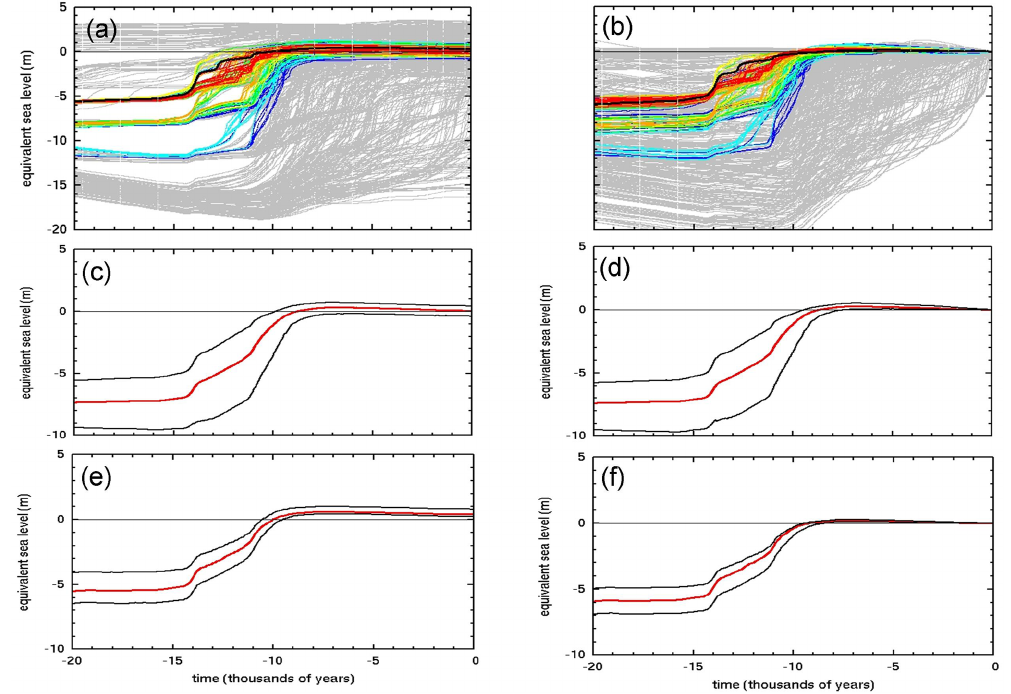
Figure 5. Equivalent global-mean sea-level contribution (ESL) relative to modern vs. time. Time runs from 20000yr before present to modern. ESL changes are calculated from the total ice amount in the domain divided by global ocean area, allowing for less contribution from ice grounded below sea level. (a) Scatterplot of all 625 individual runs in the LE. ESL amounts are calculated relative to modern observed Antarctica, so non-zero values at time = 0 imply departures from the observed ice state. Grey curves are for runs with the aggregate score S equal to or very close to 0, and colored curves are for the 120 top-scoring runs in descending S order with 20 curves per color (red, orange, yellow, green, cyan, blue). The best scoring individual run is shown by a thick black curve (OCFAC = 3, CALV = 1, CSHELF =− 5, TAUAST = 3, with S = 0.571). (b) As (a) but with ESL amounts relative to each run’s modern value, so the curves pass exactly through zero at time = 0. (c) Score-weighted curves over the whole LE, using the simple statistical method. Red curve is the score-weighted mean, i.e., (cid:54) { S (n) ESL (n) (t) } /(cid:54) { S (n) } , where S (n) is the aggregate score for run n , ESL (n) (t) is the equivalent sea-level rise for run n at time t , and the sums are over all n (1 to 625) in the LE. Black curves show the one-sided standard deviations, i.e., the root mean square of deviations for ESL (n) above the mean (upper curve) or below the mean (lower curve) at each time t . ESL (n) (t) are relative to modern observed Antarctica, as in (a) . (d) As (c) but with ESL (n) (t) relative to each run’s modern value as in (b) . (e, f) Corresponding results to (c) and (d) , respectively, using the advanced statistical techniques in Chang et al. (2016) extended as described in Sect.